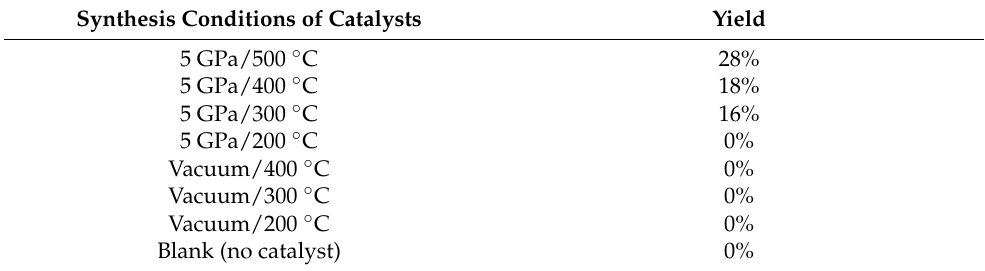
Table 4. Yields of the product in Huisgen cycloaddition over by MOF-derived Cu@C catalysts. Synthesis Conditions of